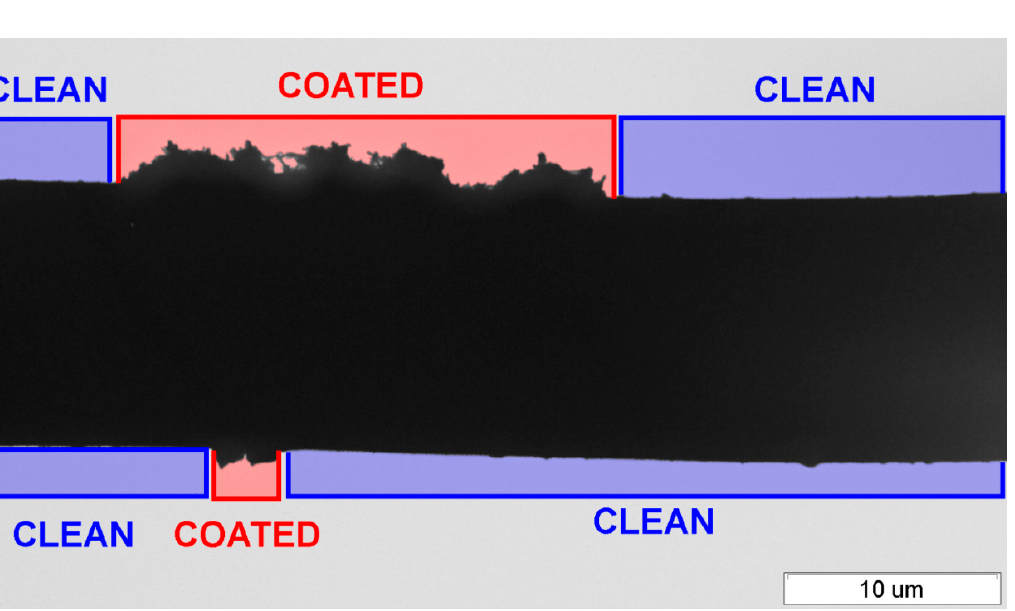
Figure 9. TEM image (low magnification) of the CNF/BMF hierarchical material sample after 5 min of sonication. Table 2. The coating coefficient ( k c ) values calculated from TEM images for the hierarchical materials studied in the present work.